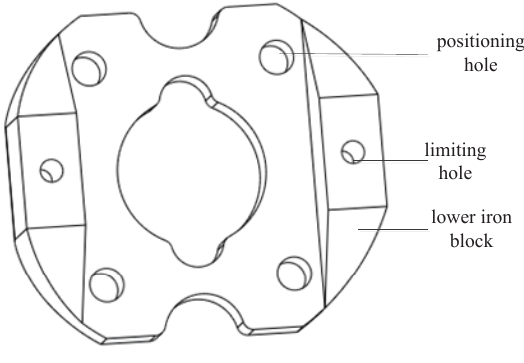
Figure 14. Positing holes and limiting holes at the lower iron